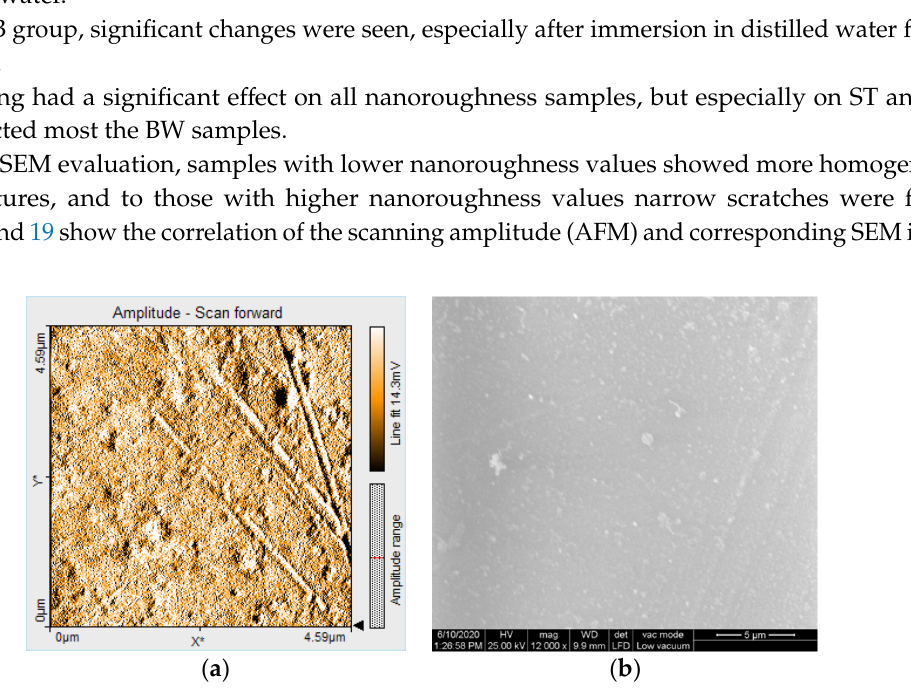
Figure 19. ( a ) Scanning amplitude (AFM) and ( b ) corresponding SEM image for a sample (BWX) with high nanoroughness values: Sa = 15 nm, Sp = 63 nm, Sv = − 54 nm. 4. Discussion The term surface quality refers to a set of widely different properties, such as color, roughness, and topography [19]. In the present study, the characteristics of color, roughness, morphology, and topography were selected to assess removable thermoplastic appliances surfaces. The surface quality is on the one hand material- and processing-related, and on the other hand subject to changes related to oral environment and cleaning methods. Polyethylene terephthalate glycol, commonly known as PETG or PET-G, is thermoplastic polyester with high chemical resistance, durability, and excellent formability for manufacturing. It can be easily thermoformed at low temperatures and is used in prosthetic and orthodontic splint therapy [20]. This kind of thermoformed materials benefit from a highly transparent appearance, but their color changes have been associated with pigment adsorption or penetration of the material surface after immersing in staining agents [10]. Variations in the color changes are attributed to the materials’ surface characteristics, such as roughness, which might accelerate pigment accumulation [16]. The study demonstrated that there is a very weak relationship between roughness and color modification. This could explain the color modification by the penetration of the material, not only by the effect on the surface. Studies related that the translucency of thermoplastic plates decreases after thermoforming, due to the modification from amorphous to crystalline structures, related to the temperature, pressure, and working time [6,21]. These investigations revealed an insignificant color change after thermoforming. Different studies suggest that the effects of temperature and water absorption on the properties of thermoplastic materials in a simulated oral environment are related to the materials [22]. Polymer